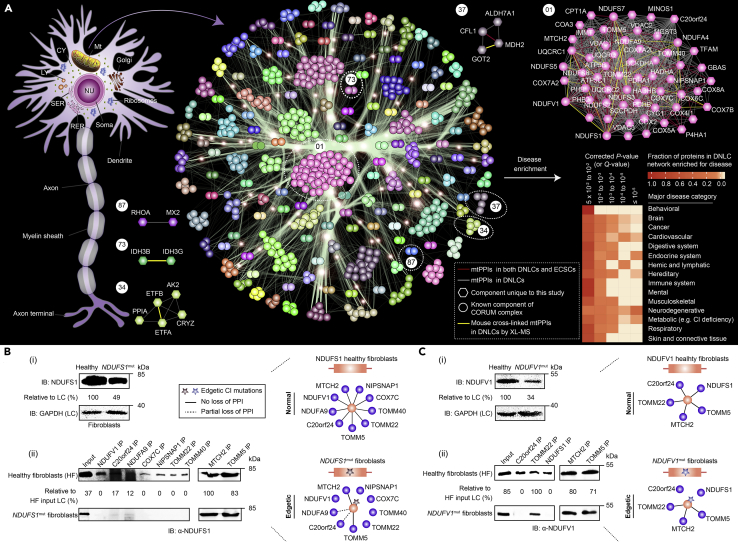
Human mt MPCs in DNLCs and Their Interacting Proteins to CI Deficiency(A) Schematic of the putative MP assemblies and representative MPCs are indicated using different colored circles, and mtPPIs (edges or lines) present in both cell states (red) and specific to DNLCs (gray) are shown along with those identified by cross-linking (XL)-MS (yellow) in different mouse tissues; hexagonal nodes are unique to this study, and circles are known component of a CORUM complex. CY, cytoplasm; SER and RER, smooth and rough ER, respectively; LY, lysosome. Enrichment of mtPPIs from DNLC network linked to human diseases; false discovery rate (Benjamini-Hochberg correction)-adjusted p value (or Q-value) of the hypergeometric test.(B and C) NDUFS1 (B-i) or V1 (C-i) levels and perturbation of select PPI pairs in the fibroblasts of healthy individual and CI-deficient subject with NDUF mutations (B-ii, C-ii) immunoblotted (IB) with anti-NDUFS1 or VI antibody. Band intensities were normalized to GAPDH or healthy fibroblast (HF) input loading control (LC). Molecular masses (kDa) of marker proteins are indicated.See also Figure S4 and Table S3.